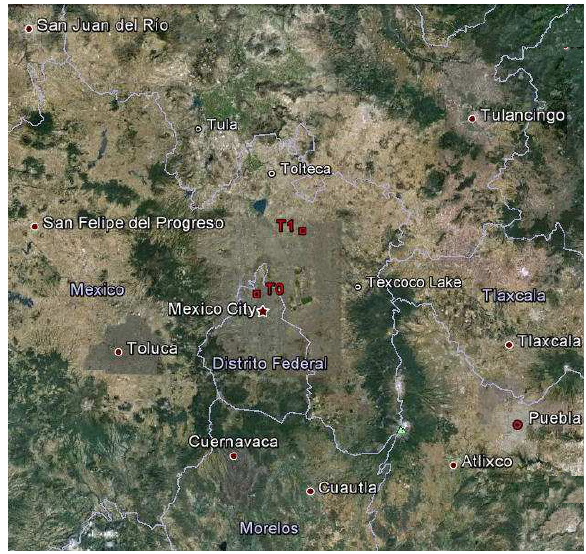
Figure 1: The modeling domain for the Mexico City Metropolitan Area during the MILAGRO Fig. 1. The modeling domain for the Mexico City Metropolitan campaign. It also shows the locations of the monitoring stations during the campaign . Area during the MILAGRO campaign. It also shows the locations of the monitoring stations during the